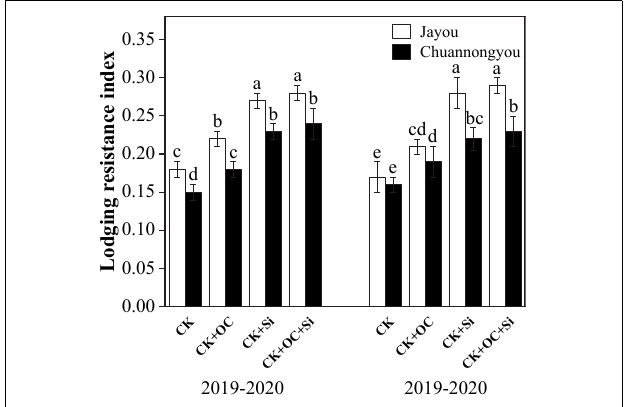
FIGURE 3 | Effect of different fertilization treatments on the lodging resistance index. Different lower-case letters indicate significant differences among treatments at p ≤ 0.05 (LSD test). The CK, CK + OC, CK + Si, and CK + OC + Si represent the conventional fertilization, conventional + organic carbon fertilization, conventional + silicon fertilization treatment, and conventional + organic carbon + silicon fertilization